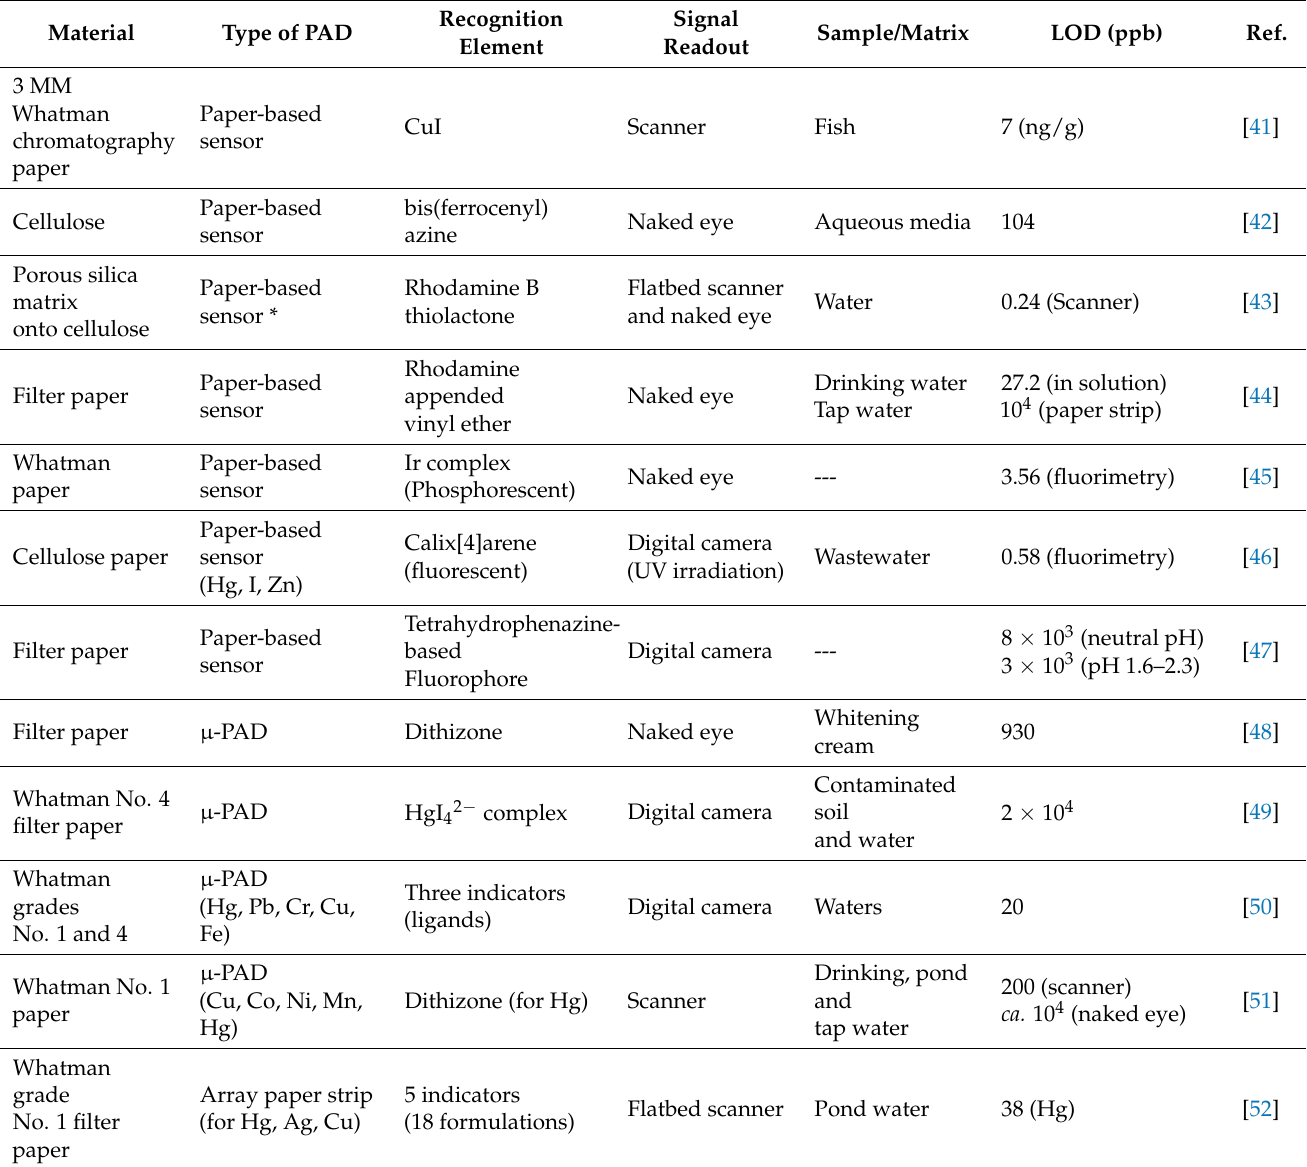
Table 1. Applications of chromogenic/fluorogenic reagents as receptors in PADs ( µ -PADs and paper-based sensors) for the detection of